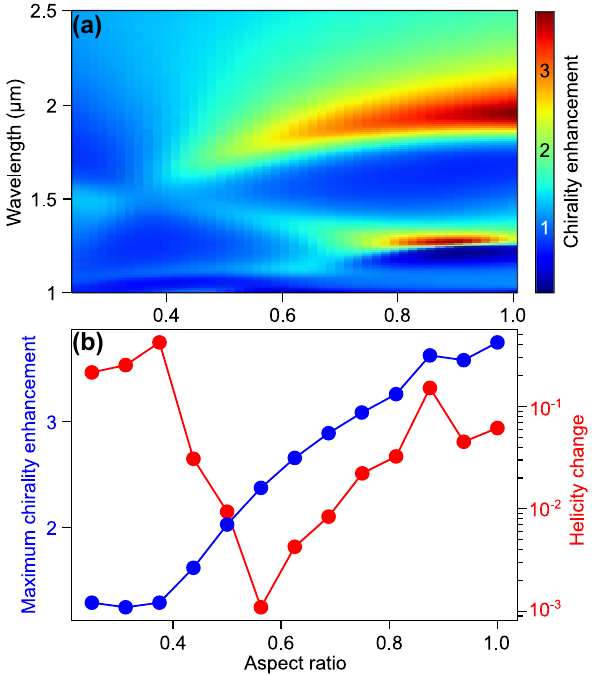
Figure 2: Tuning chirality enhancement with aspect ratio. (a) Surface averaged chirality enhancement spectra as a function of aspect ratio  for water-embedded HID nanodisks with fixed volume of 5 × 10 7 nm 3 . For flat disks the enhancement is generally low. For tall disks two contributions are present: dipolar around 1750–2000 nm and quadrupolar around 1250 nm. (b) Maximum surface averaged chirality enhancement as a function of AR and corresponding helicity change. Note how chirality